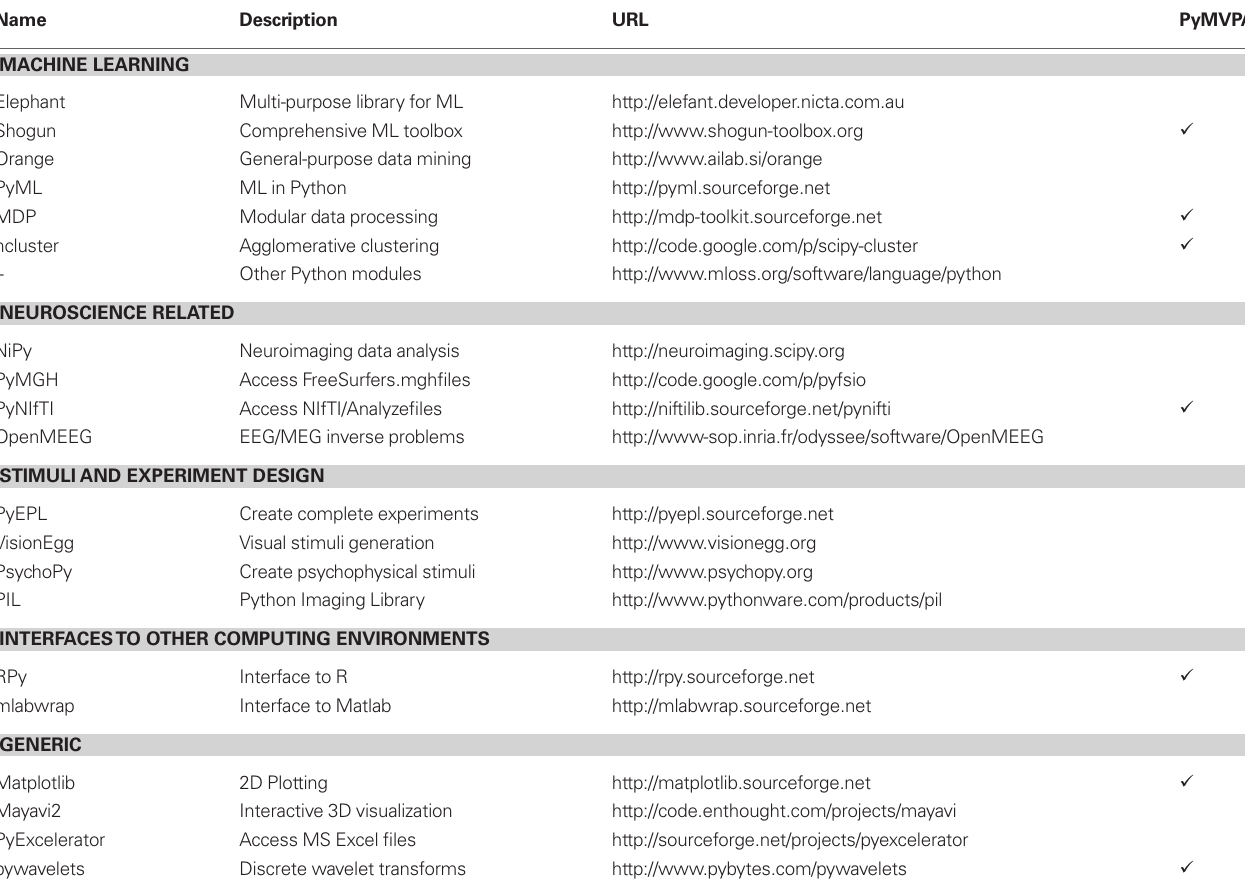
Table 1 | Various free and open-source projects, either written in Python or providing Python bindings, which are germane to acquiring or processing neural information datasets using machine learning (ML) methods. The last column indicates whether PyMVPA internally uses a particular project or provides public interfaces to